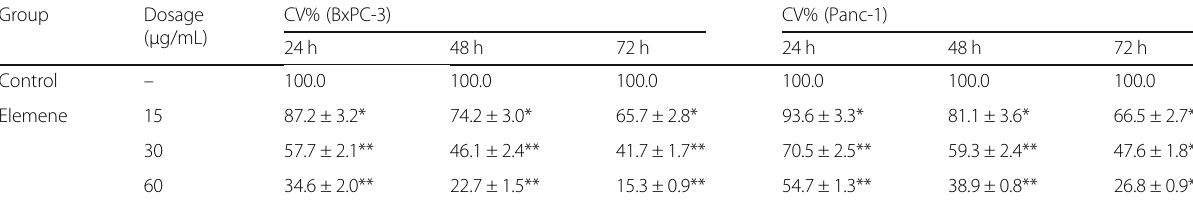
Table 1 Anti-proliferation activity for elemene on BxPC-3 and Panc-1 cell line